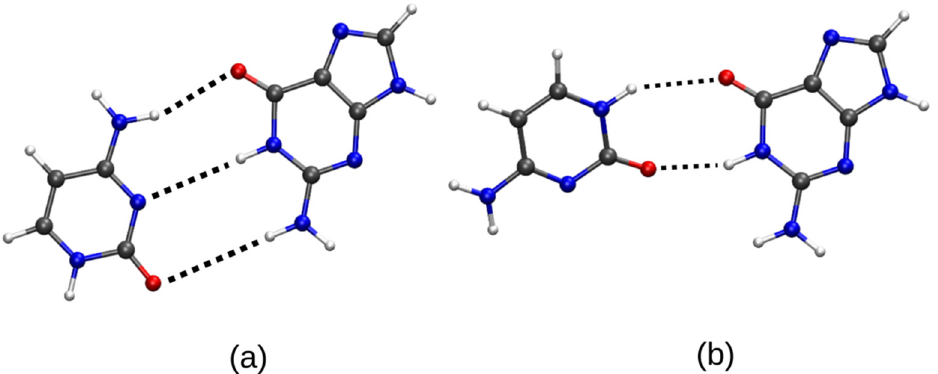
Figure 4. E dua l global minima ( a ) vs. local minima ( b ) of the guanine (G)–cytosine (C) complex. Carbon atoms are in grey, Nitrogen atoms in blue, Oxygen atoms in red and Hydrogen atoms in white.